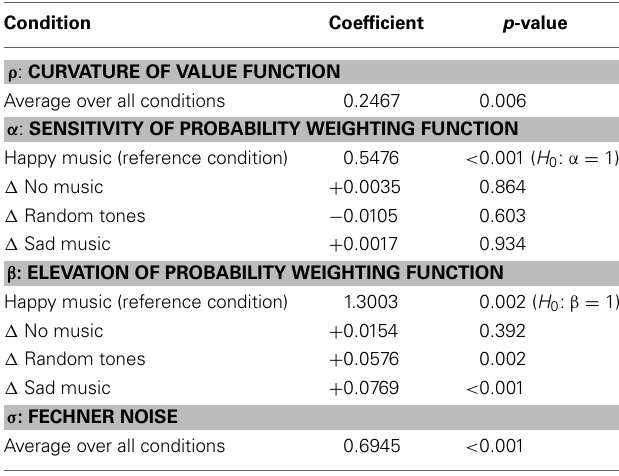
Table 2 | Structural regression model: estimates of preference parameters—sensitivity and elevation of the probability weighting function in the “happy music” condition as well as changes of the parameters in the remaining